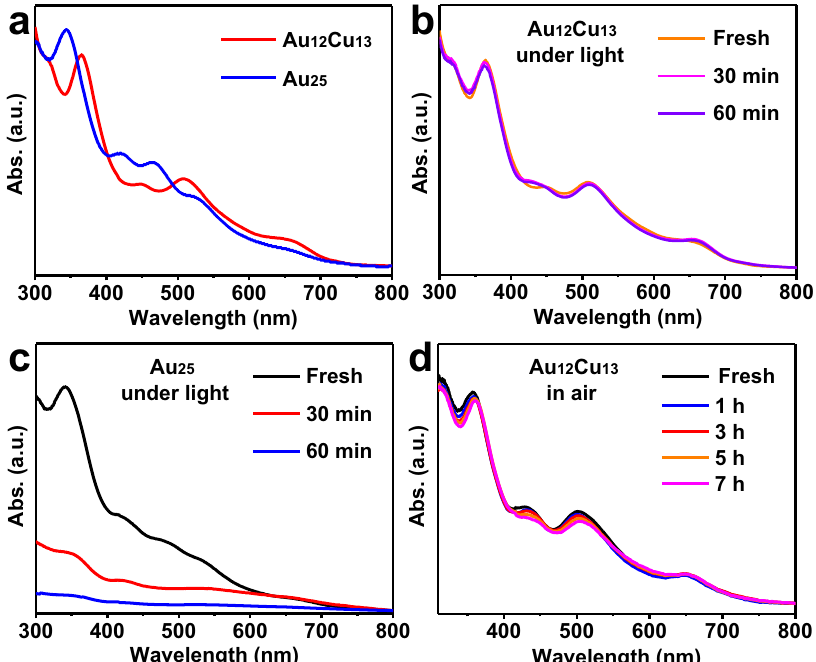
Fig. 4 Stability of Au 12 Cu 13 clusters. a UV-vis spectra of Au 12 Cu 13 and Au 25 nanoclusters. Stability tests of Au 12 Cu 13 and Au 25 clusters: b , c under sunlight and d in air.